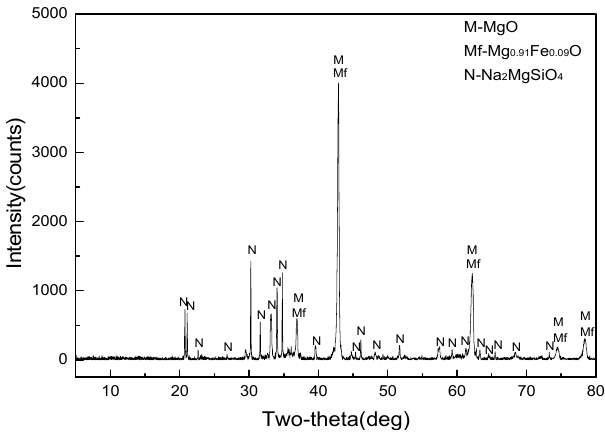
Figure 2. XRD pattern of the MgO-enriched residue.